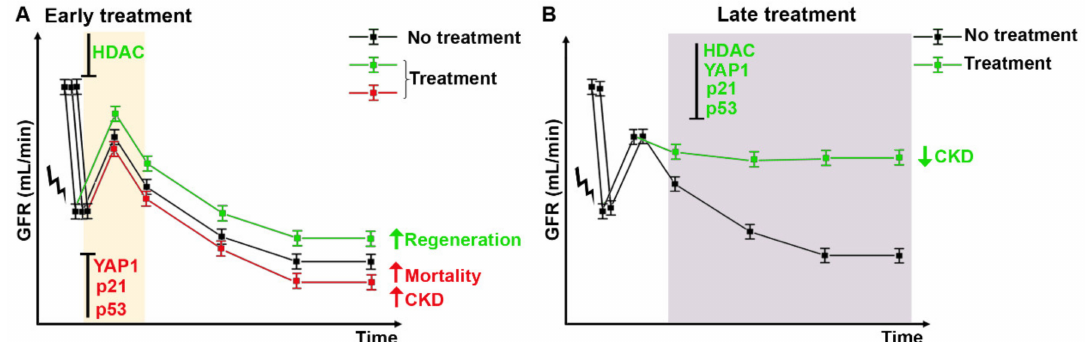
Figure 3. Windows of opportunity for potential druggable targets to treat AKI and avoid CKD progression. ( A ) Early treatment after AKI with HDAC inhibitors enhance kidney regeneration (green line) by promoting RPC proliferation. Conversely, early treatment with drugs that inhibit cell cycle arrest and/or polyploidization (p21, p53, and YAP1 inhibitors) increase mortality of mice and lead to CKD (red line). ( B ) Late treatment, after the acute phase of damage, with drugs that inhibit cell cycle arrest and/or polyploidization (p21, p53, HDAC, and YAP1 inhibitors) ameliorates kidney function and prevents fibrosis and senescence (green line). GFR: glomerular filtration